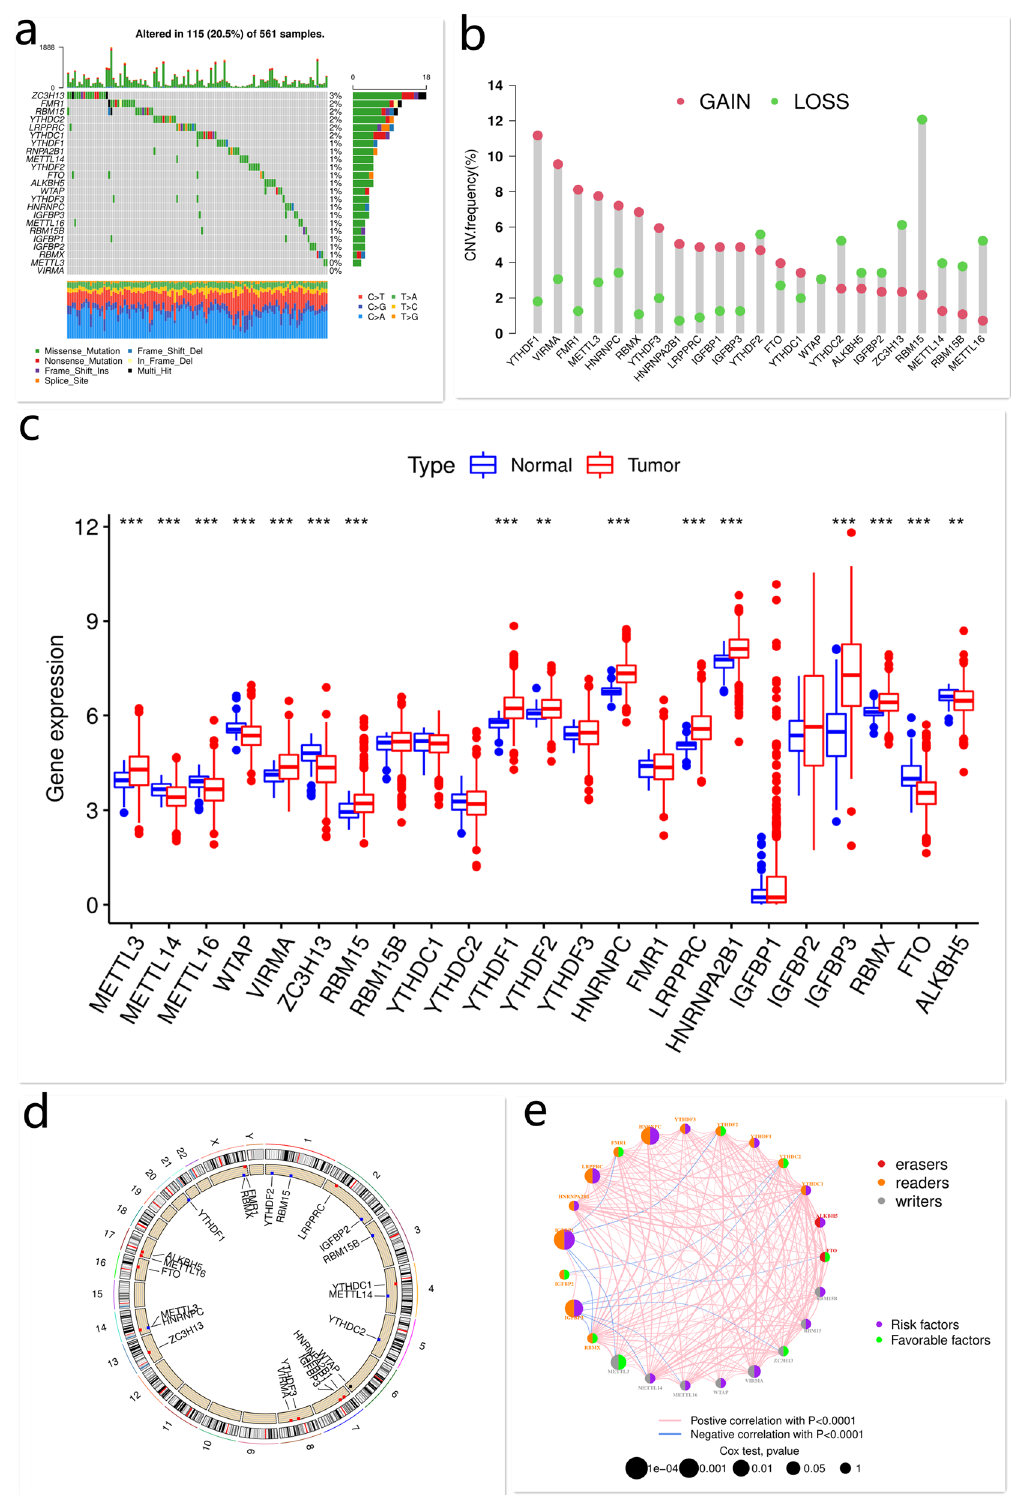
Figure 1. The expression, mutation characteristics, and relation of m 6 A regulators in LUAD. The mutation frequency of m 6 A regulators in LUAD ( a ). The CNV frequency of m 6 A regulators in LUAD. Blue dots indicate deletion frequency, while red dots indicate amplification frequency ( b ). The expression of m 6 A regulators in LUAD ( c ). The location of CNV alteration of 23 m 6 A regulators on chromosomes ( d ). The relation of m 6 A regulators in LUAD. The circle size indicates the survival impact of each m 6 A regulator. The lines connecting m 6 A regulators indicate their relations. The thickness of line indicates the strength of the relation. The red lines indicate positive relations, while the blue lines indicate negative relations ( e ). This figure is created using the R (version 4.0.3) (https:// www.r- proje ct.